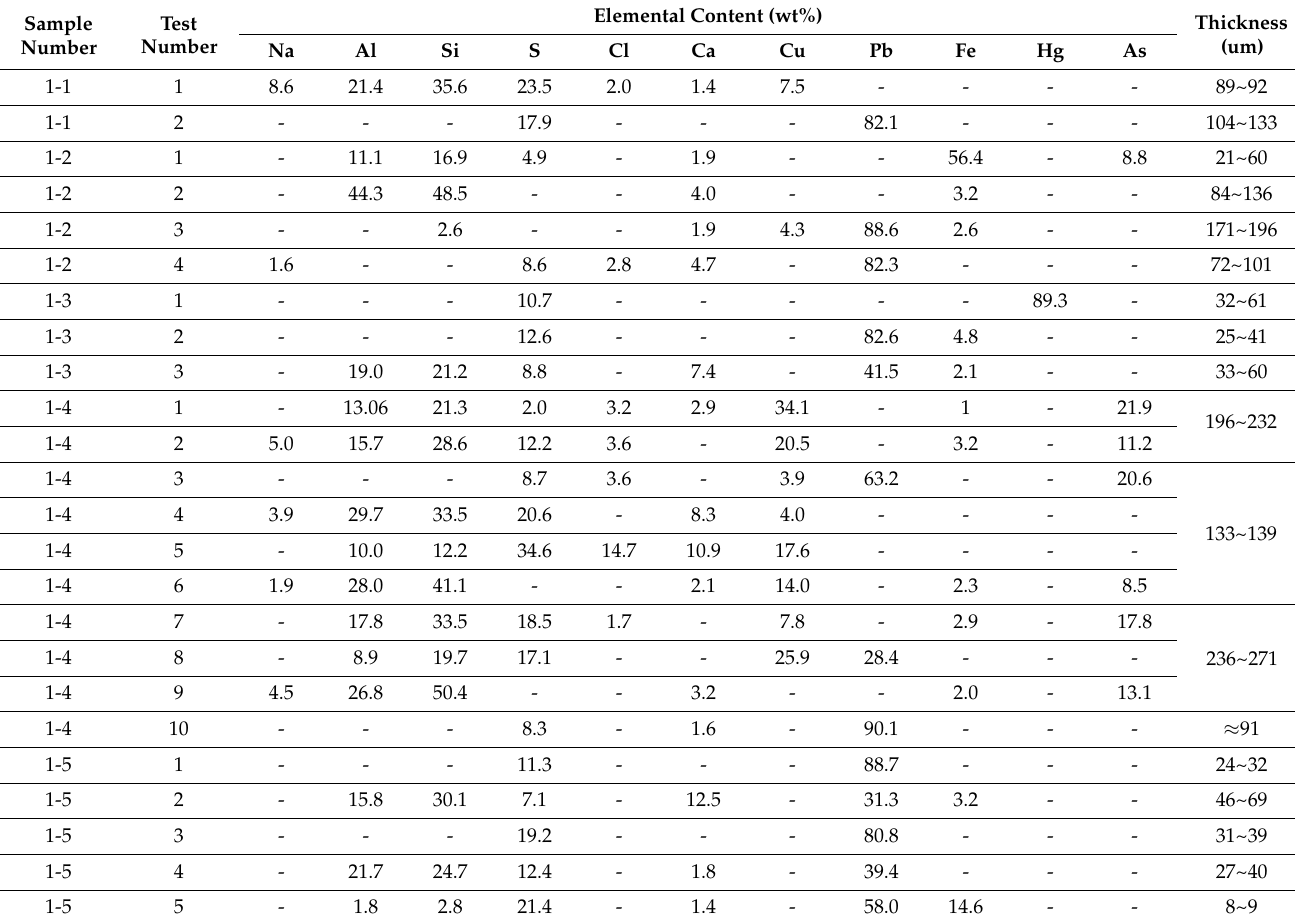
Table 3. Statue No.CS1, Sage Mother Hall: SEM-EDS and cross-section results.